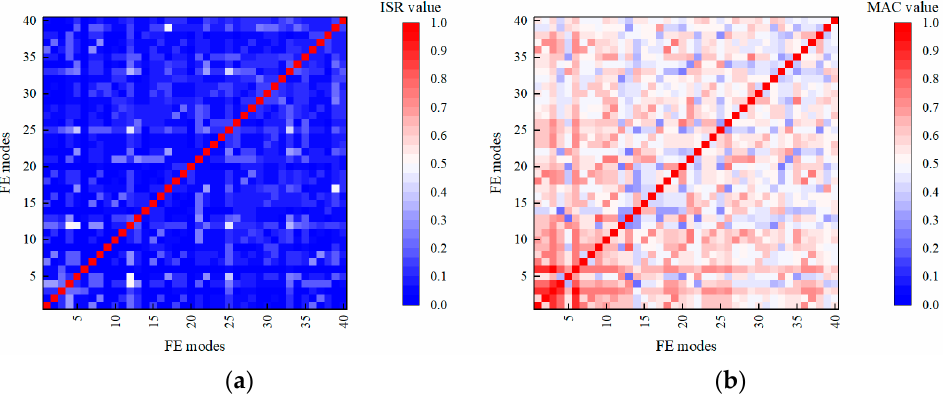
Figure 8. Auto-correlation of FE mode shapes based on different mode-identification indices (the closer the color is to red, the higher the similarity is, while the closer the color is to blue, the lower the similarity is). ( a ) Auto-correlation of FE mode shapes based on ISR and ( b ) Auto-correlation of FE mode shapes based on MAC.